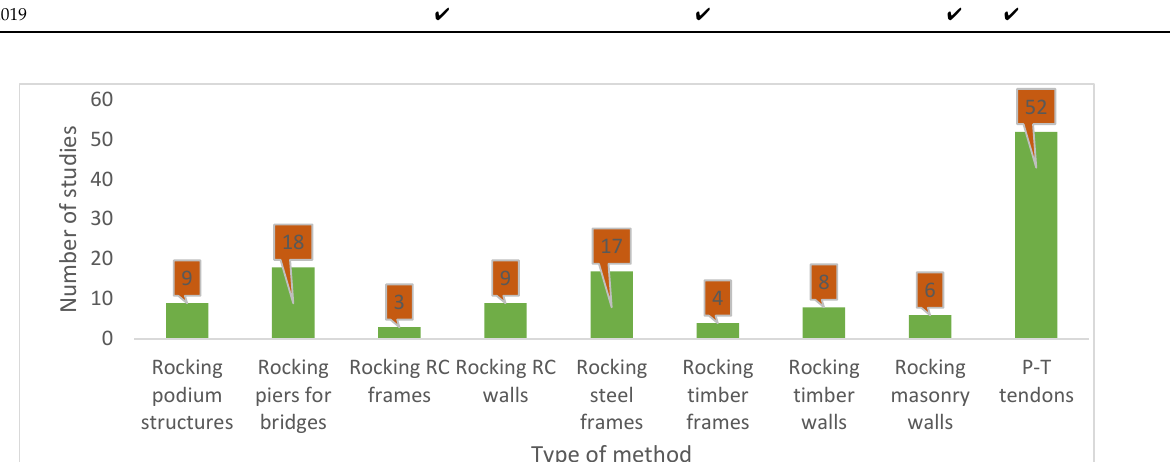
Figure 9. Visualization of the summarized research based on the investigated components.